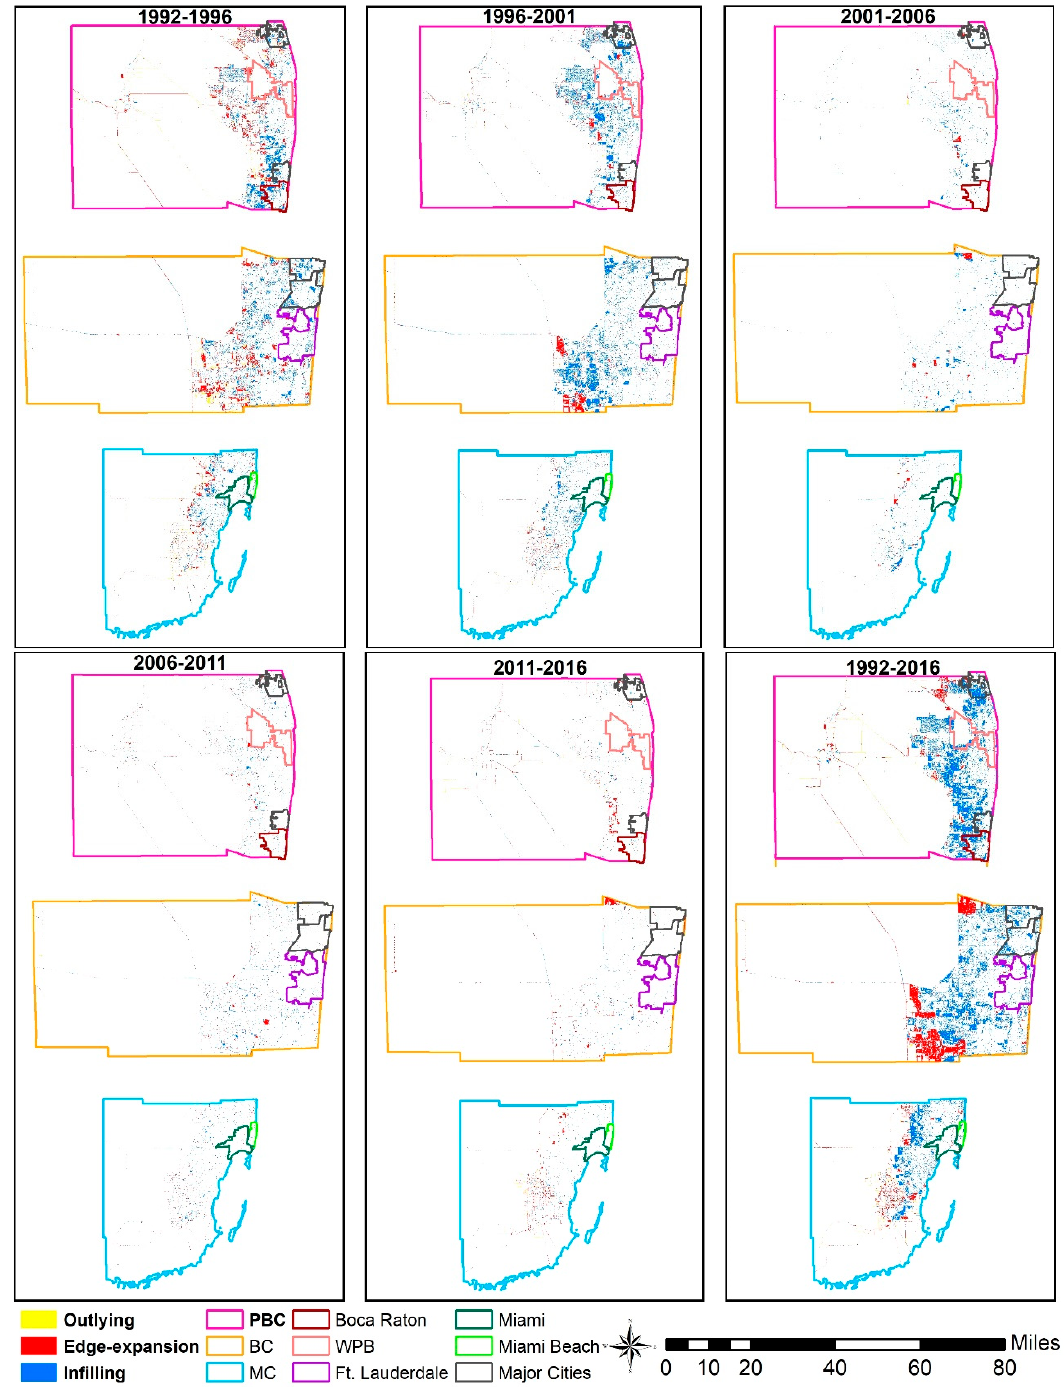
Figure 13. Urban expansion types in di ff erent time periods in PBC, BC, and MC.